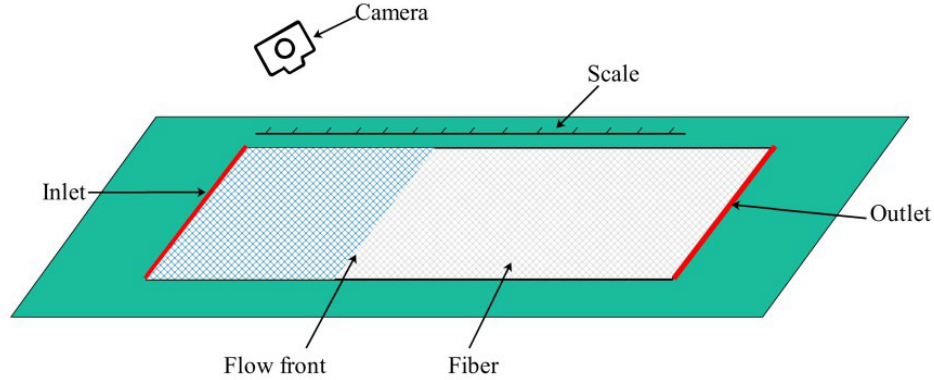
Figure 3. Schematic of experimental setup for the permeability measurement.